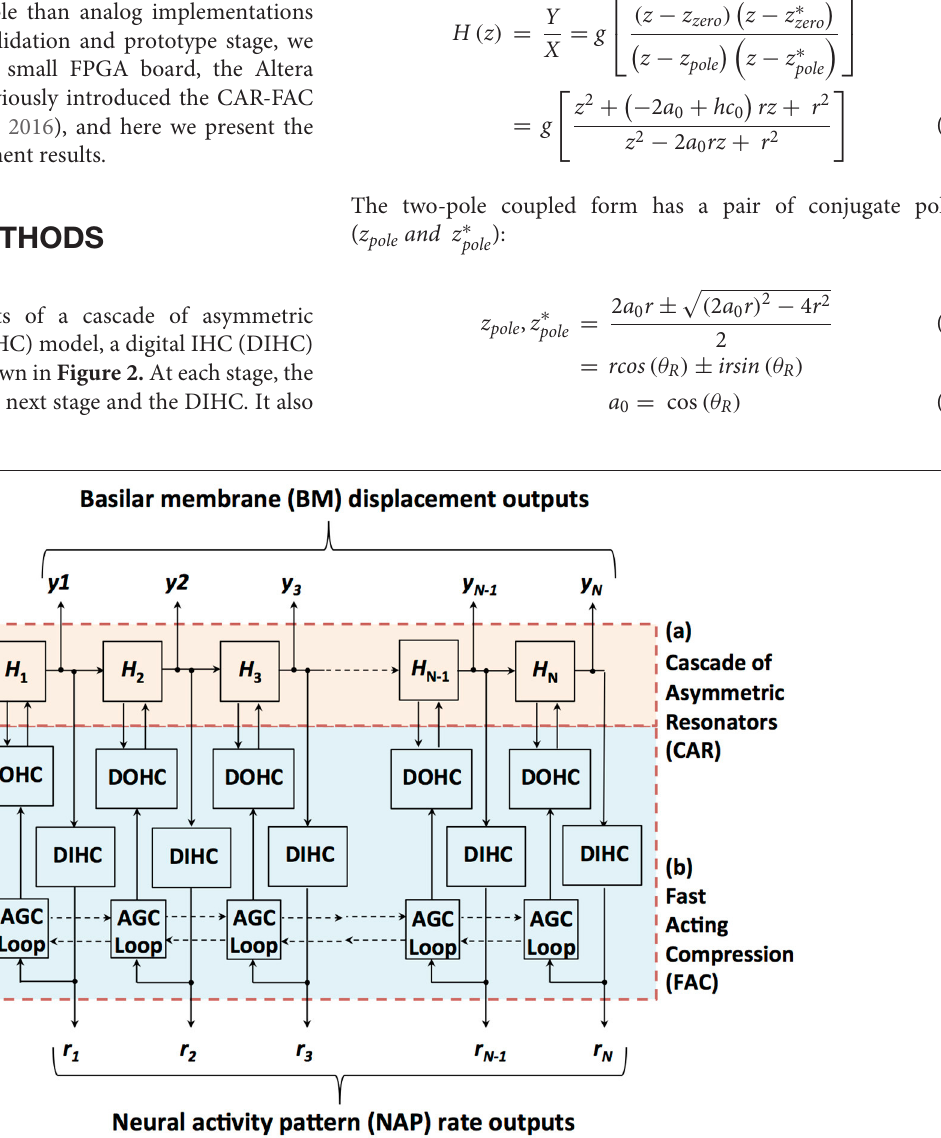
FIGURE 2 | Structure of the CAR-FAC model. x is the input sound, H 1 to H N are the transfer functions of the CAR part, and y 1 to y N represent the CAR-FAC output. The CFs of the CAR resonators decrease from left to right. The DOHC, the DIHC and the AGC loop comprise the FAC part. The neural activity pattern (NAP) rate outputs, r 1 to r N , are estimations of average instantaneous nerve firing